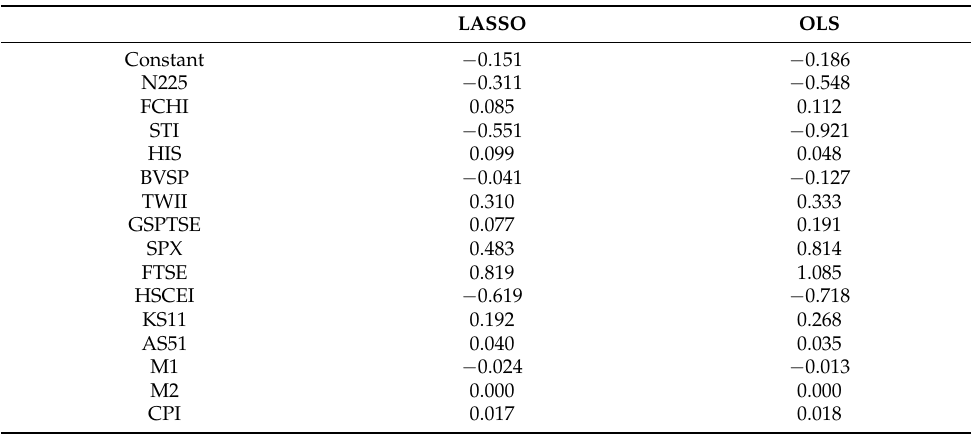
Table A3. Parameter estimates from LASSO and OLS